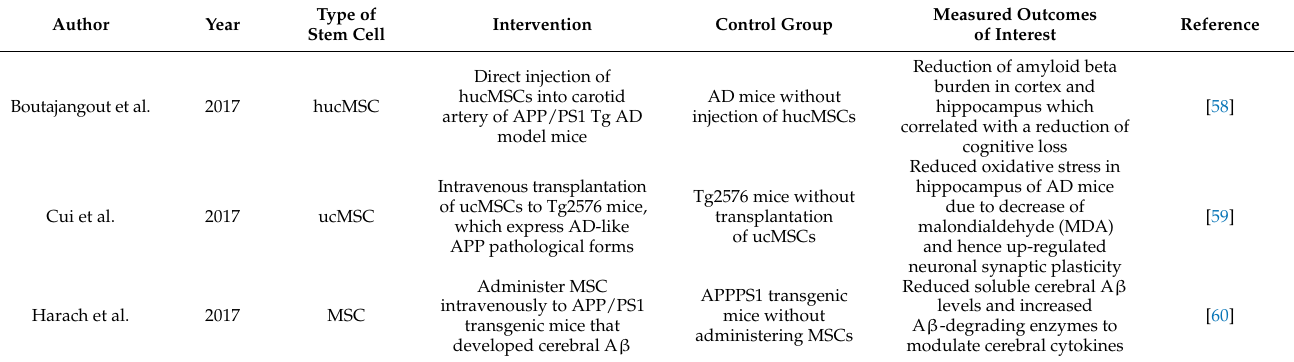
Table 2. Summary of animal model studies on stem cell therapy for AD in chronological order